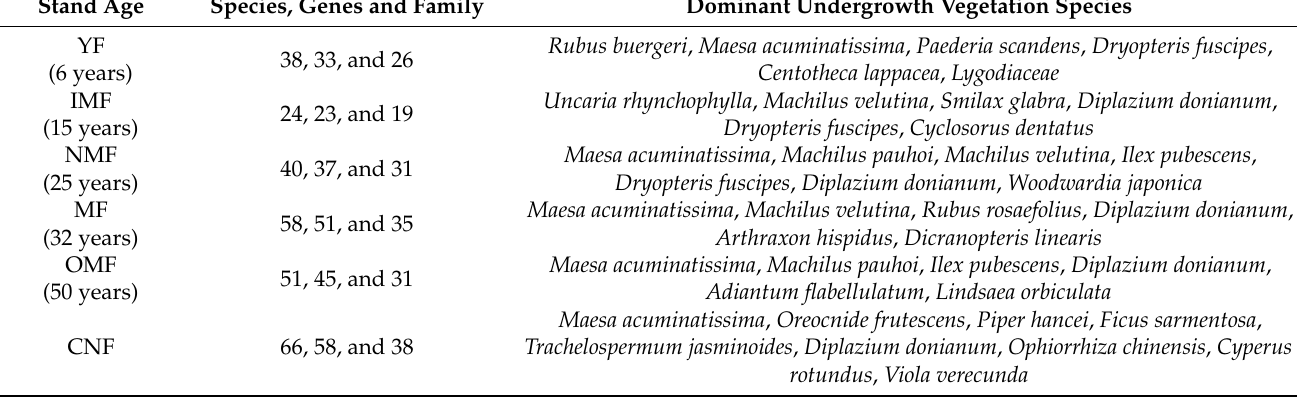
Table 3. Plant diversity survey under different stand ages of Chinese fir forest. Species, genes, and family mean plant species presented for the same stand ages belong to different taxa. Dominant undergrowth vegetation species were ranked by species importance values for the same stand ages.